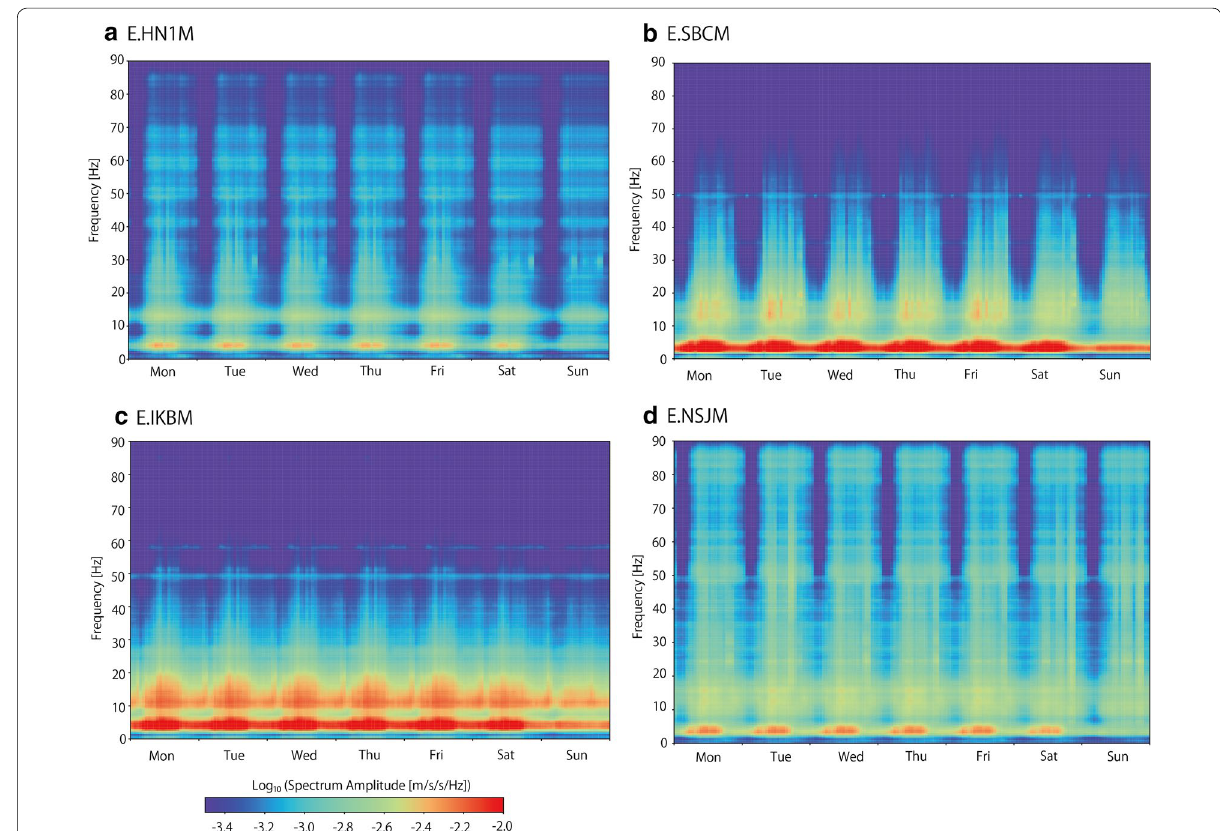
Fig. 4 Average noise level of UD components at four